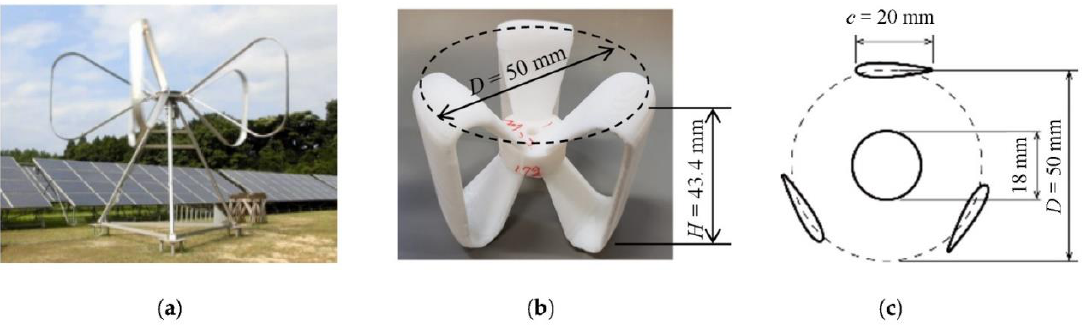
Figure 1. Butterfly Wind Turbine: ( a ) 7-m turbine; ( b ) 3-D-printed model; ( c ) cross section.